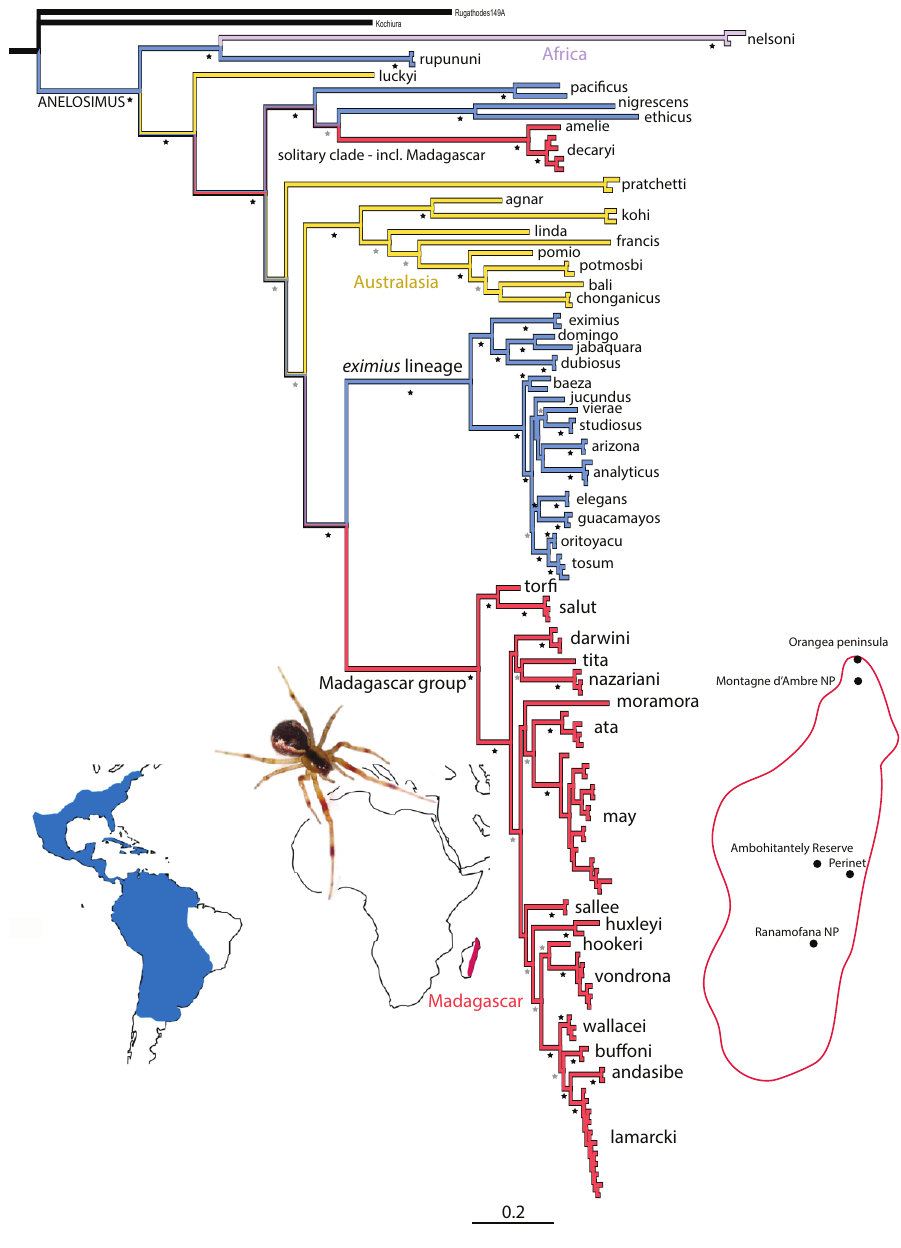
Figure 1. A Bayesian phylogeny of Madagascar Anelosimus and worldwide relatives. Terminal taxa are replaced by species names, full results including all taxon details are found in Suppl. material 1. Black stars indicate 100 posterior probability support, gray stars 85–99%. The replicated sister relationship between Madagascan and American clades is highlighted in blue and red, with the total distribution of each lineage indicated on the maps in lower left. Dots on right map indicate collection localities for the current study. Spider photograph is of the European Anelosimus vittatus , adapted from a photo by Glenn Halvor